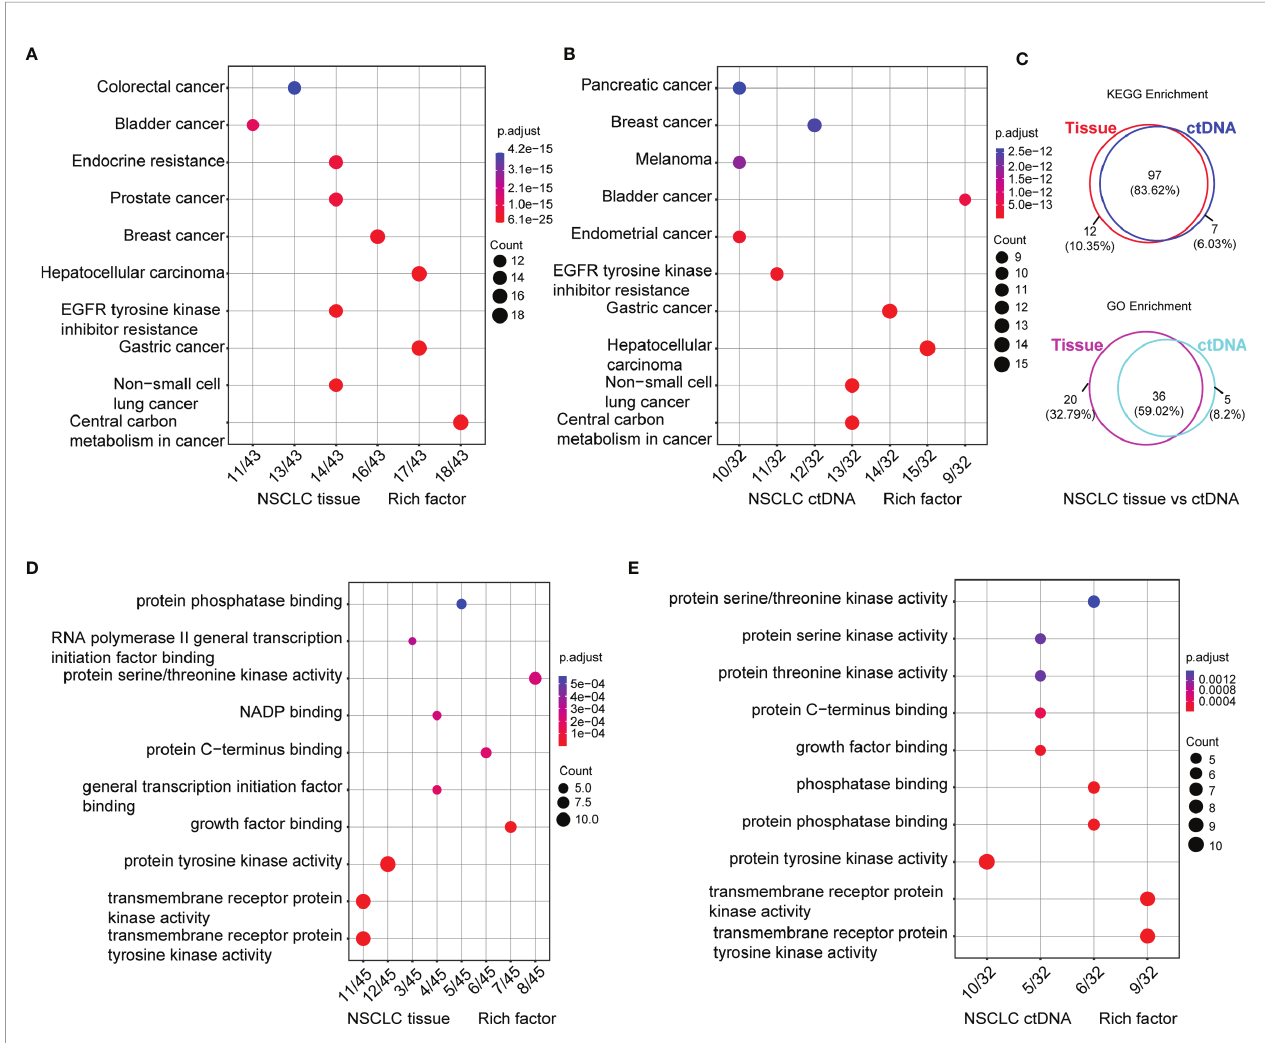
FIGURE 4 | Signaling pathways by KEGG (A, B) and functional terms by GO (D, E) enrichment of somatic mutations in tumor tissue DNA (n = 213) (A, D) and ctDNA (n = 139) (B, E) . Count means the number of mutated genes enriched in this pathway. Venn diagram of signaling pathways and functional terms enriched by KEGG and GO in NSCLC, respectively ( C , up,